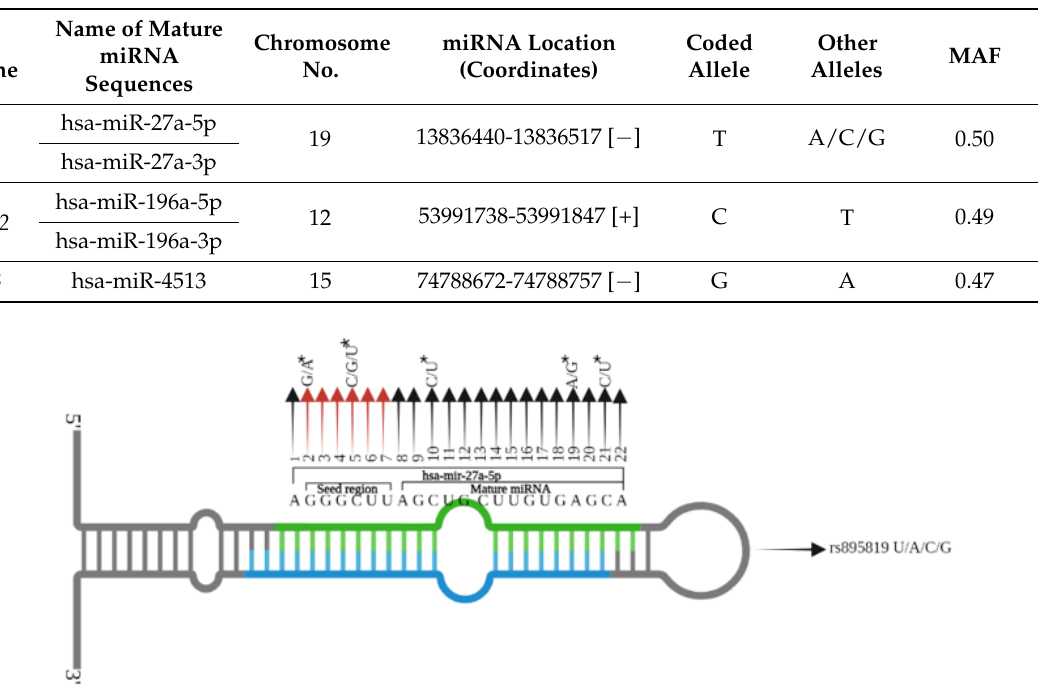
Table 2. Shows the list of studied SNPs, their official name, mature miRNA sequences, chromosomal location, and MAF.